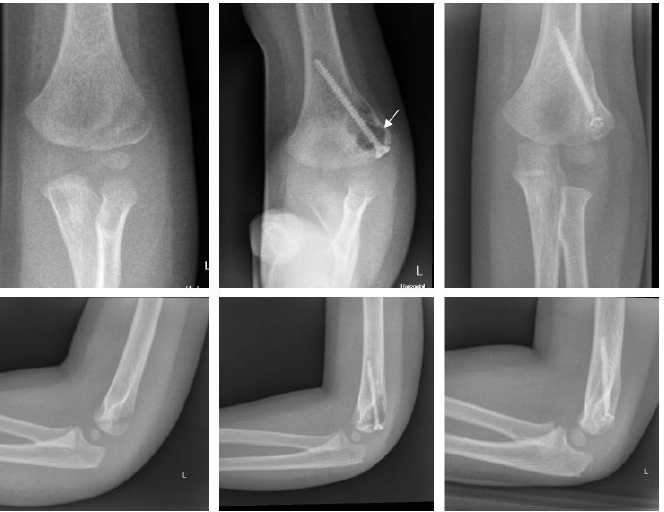
Figure 5. Fracture of lateral condyle with Magnezix ® screw: preop, 1 month postop, 12 months postop (left to right). Arrow marking gas formation.